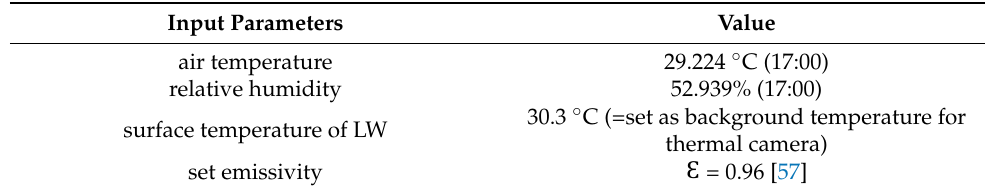
Table 2. The input parameters for the thermographic camera measurement.